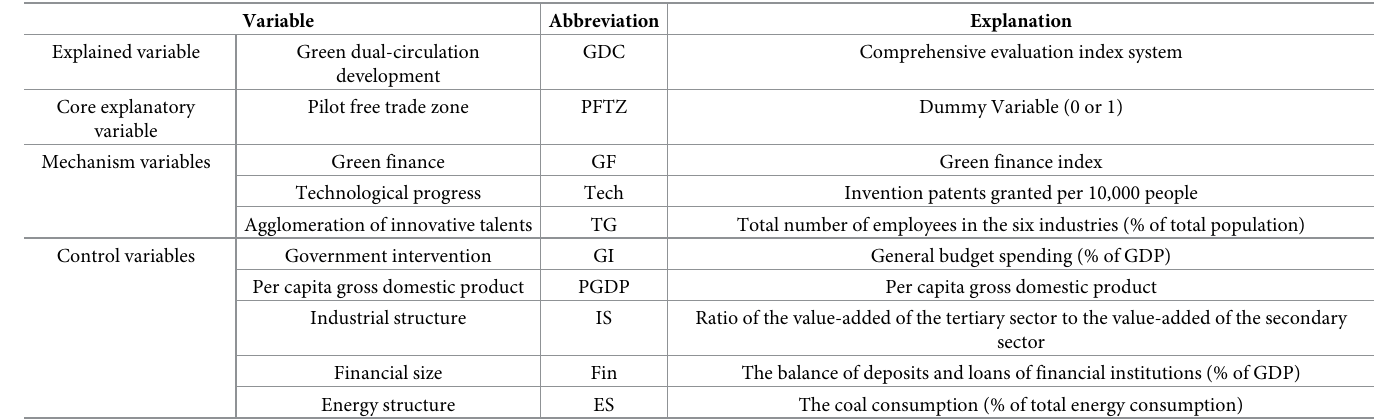
Table 2. List of abbreviations and explanations of all